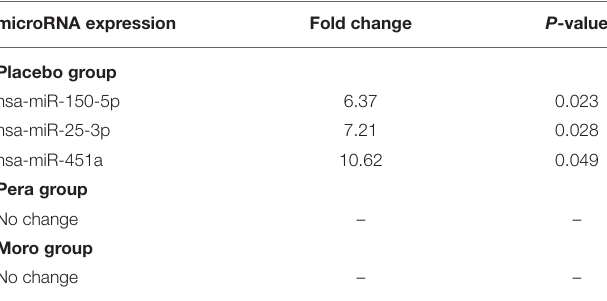
TABLE 3 | Circulating miRNAs that are differently expressed after beverage intake in the three